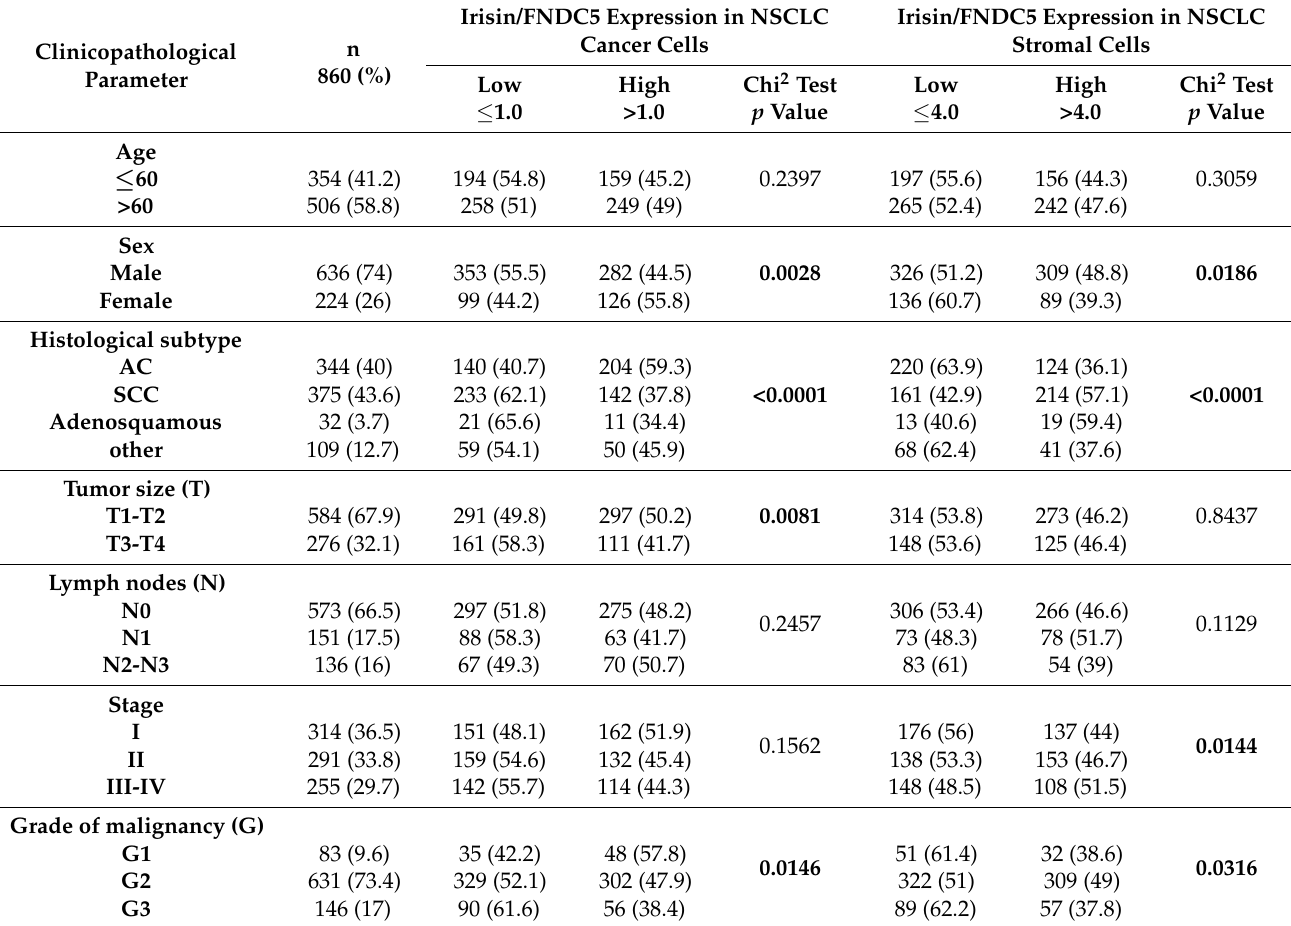
Table 1. Clinicopathological characteristics of patients with non-small cell lung cancer (NSCLC) related to low and high expression of irisin/FNDC5 (Chi 2 test analysis), significance in